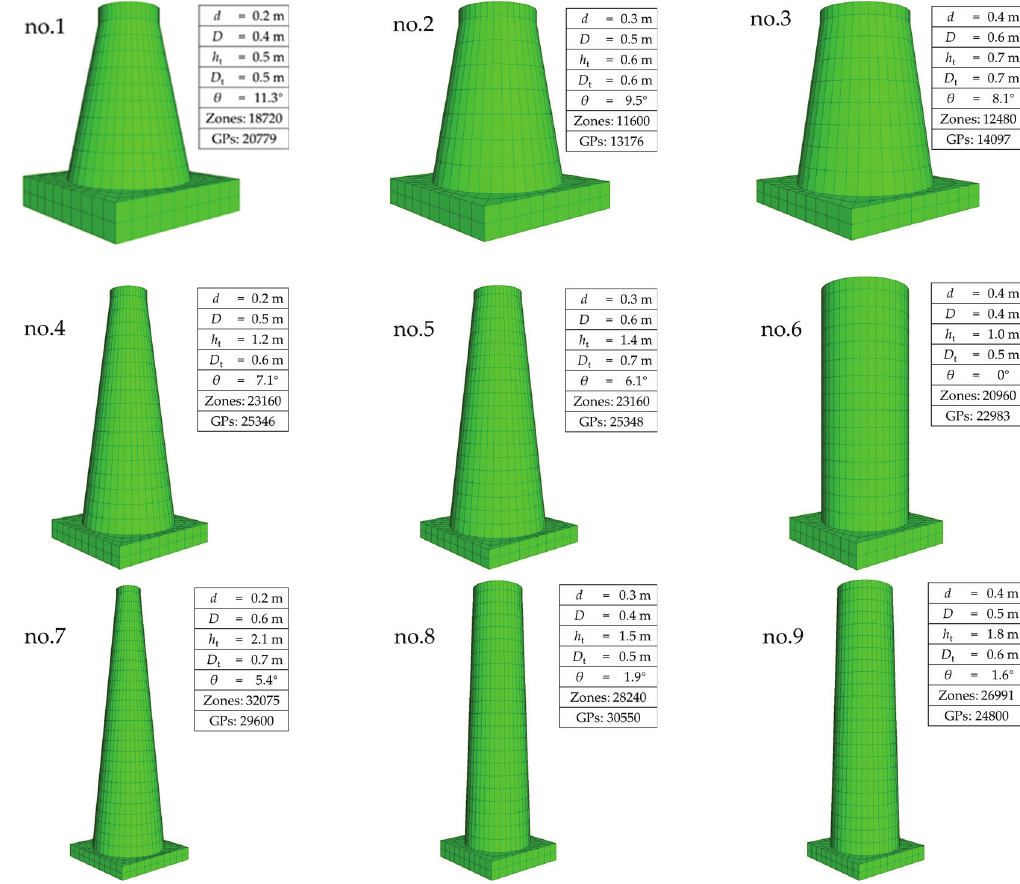
Figure 12. Schematic diagram of nine simulation foundations